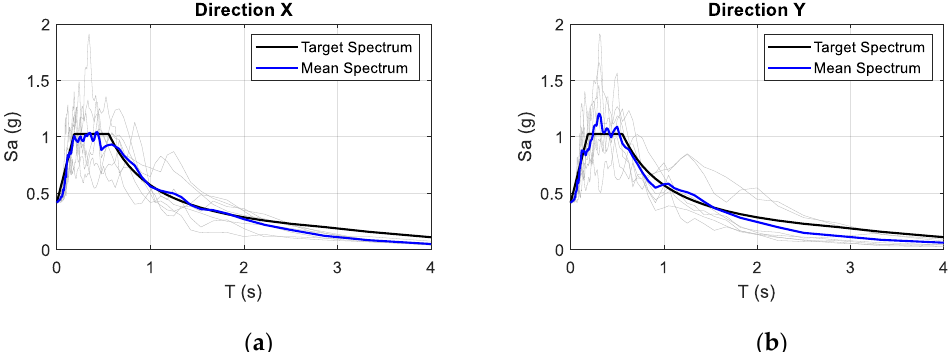
Figure 2. Natural ground motions mean spectrum and target spectrum of the selected site for ( a ) X and ( b ) Y directions.